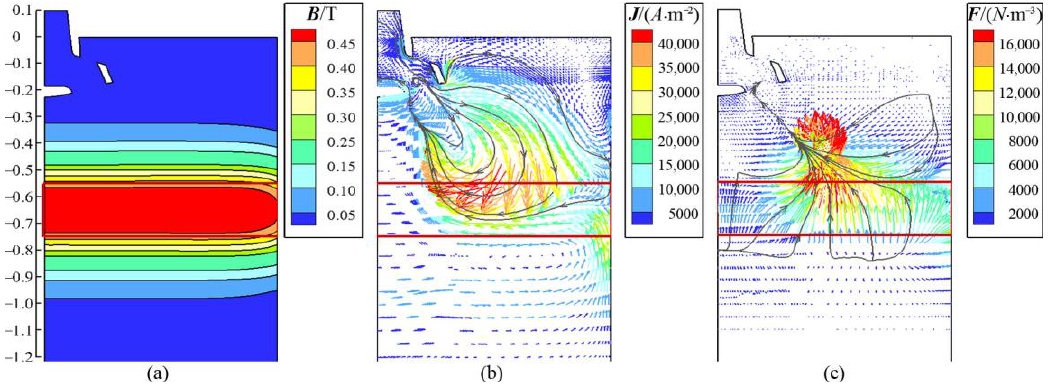
Figure 11. Electromagnetic characteristics in the central plane of the FTSR mold: ( a ) magnetic flux density, ( b ) induced current density, and ( c ) electromagnetic force.